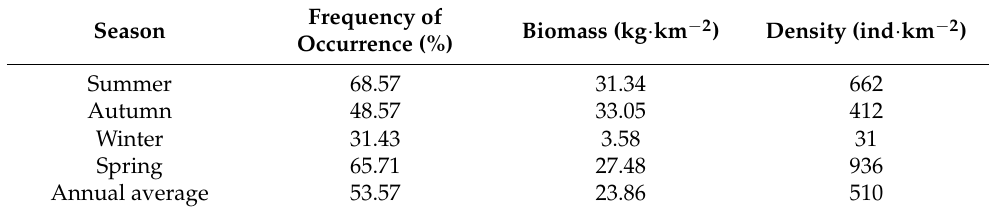
Table 1. Evynnis cardinalis resource status in northern continental shelf waters of the South China Sea,